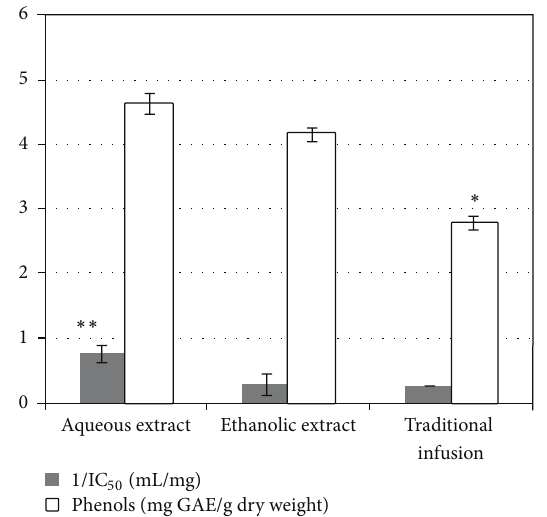
Figure 1: Antioxidant capacity ( DPPH scavenging activity ) a and total phenol content of different extracts of B. orellana seed samples ( DW ) b . Data expressed as mean ± standard deviation ( 𝑛 = 3 ). a : 1,1- diphenyl-2-picrylhydrazyl (DPPH) scavenging activity expressed as inhibitory concentration (1/IC 50 ); ∗∗ : significant 𝑃 < 0.05 . b : Phenol content expressed as mg GAE/g dry weight; ∗ : significant 𝑃 < 0.05